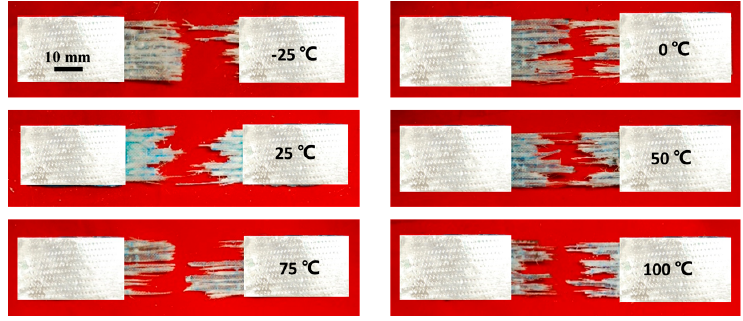
Figure 12. Fracture morphologies of GFRP under different temperatures.